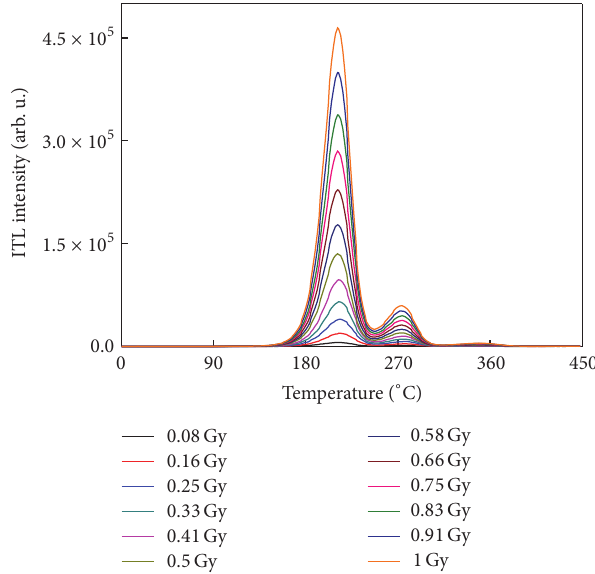
Figure 5: Thermoluminescence glow curves of pellet-shaped CaSO 4 :Eu samples, after being exposed to beta particle irradiation in the 0.08–1.0 Gy dose